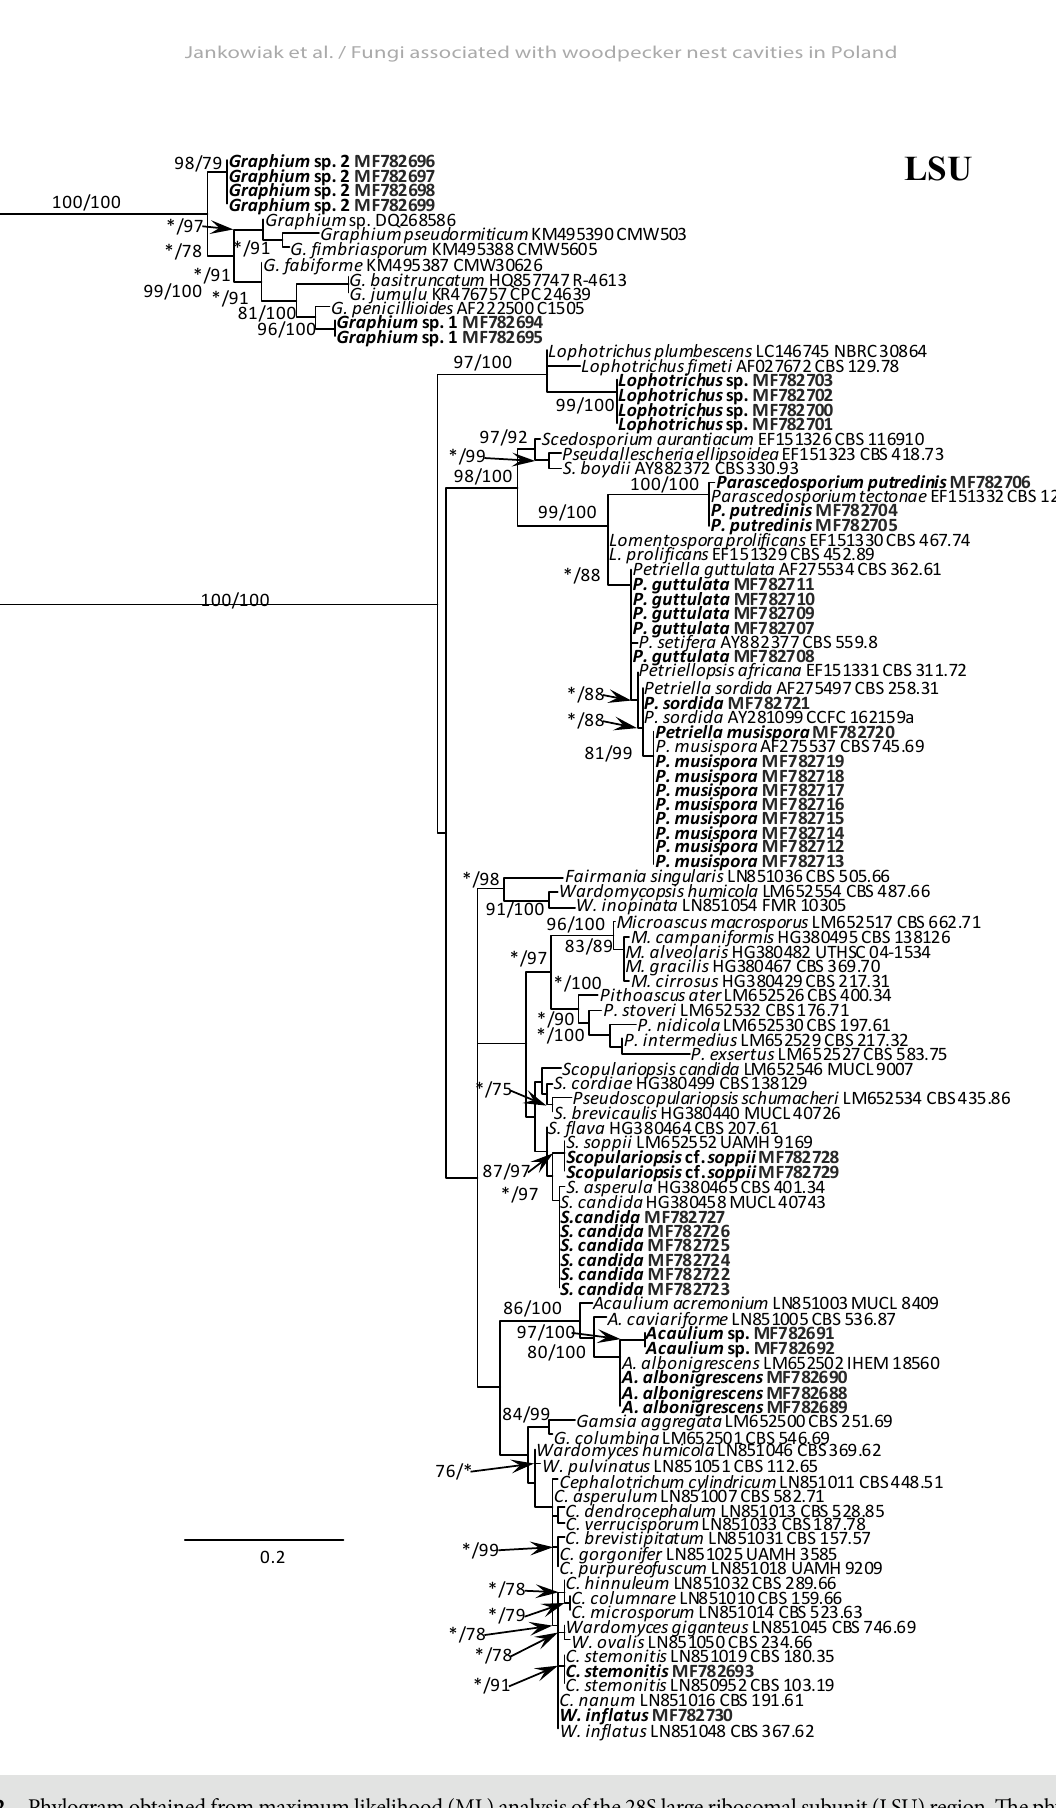
Fig. 2 Phylogram obtained from maximum likelihood (ML) analysis of the 28S large ribosomal subunit (LSU) region. The phylogram shows the placement of isolates representing the order Microascales. Sequences obtained during this study are presented in boldface. Bootstrap values >75% for ML and posterior probabilities >75% obtained from Bayesian (BI) analysis are presented at nodes as fol- lows: ML/BI. * Bootstrap values